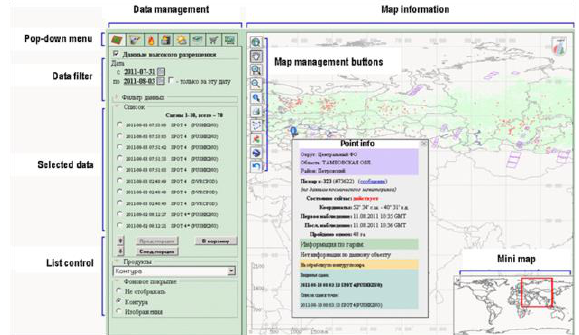
Figure 2. Basic structure of GEOSMIS user’s interface (Savorskiy,